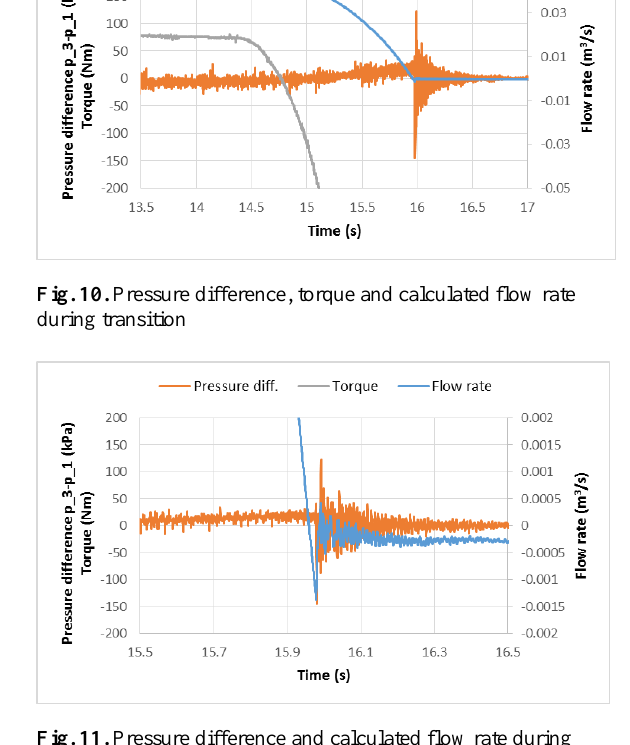
Fig. 11. Pressure difference and calculated flow rate during transition –